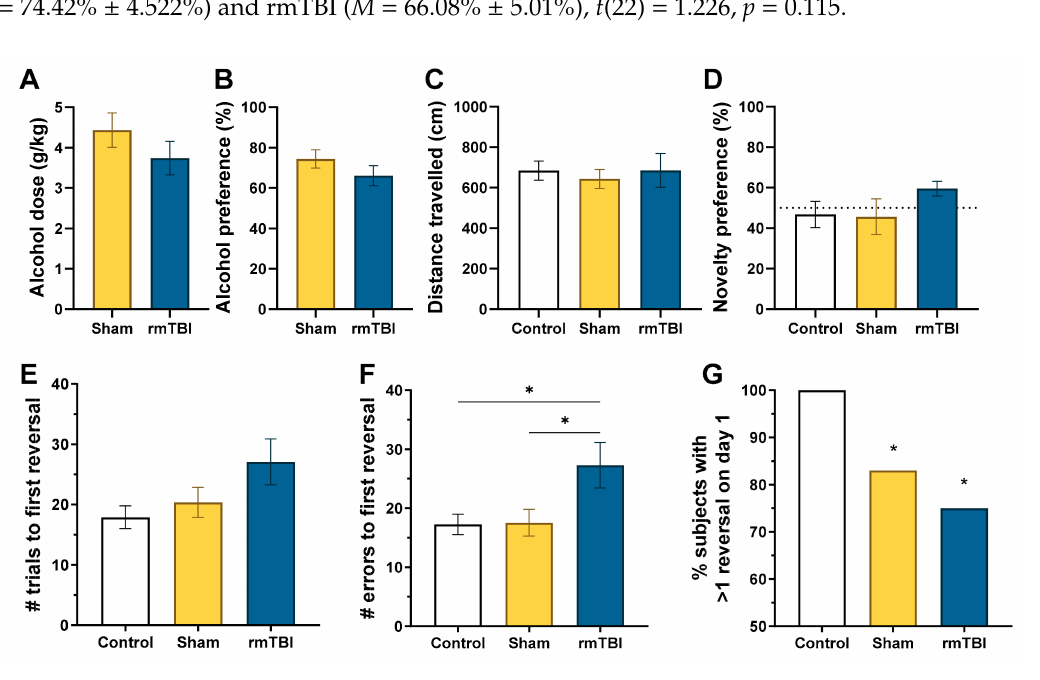
Figure 3. rmTBI + alcohol drinking resulted in mild behavioral flexibility deficits: ( A ) alcohol intake and ( B ) preference ( n = 12 / group); ( C ) no di ff erences in locomotor activity or ( D ) novelty preference were observed (control n = 12, sham n = 12, rmTBI n = 11). ( E ) The number of trials required to reach first reversal; ( F ) the number of errors committed prior to first reversal are a more sensitive measure of deficits in behavioral flexibility; ( G ) the number of mice able to achieve at least one reversal in the first n = 11, rmTBI n = 11); * significantly di ff erent from control group (exact binomial